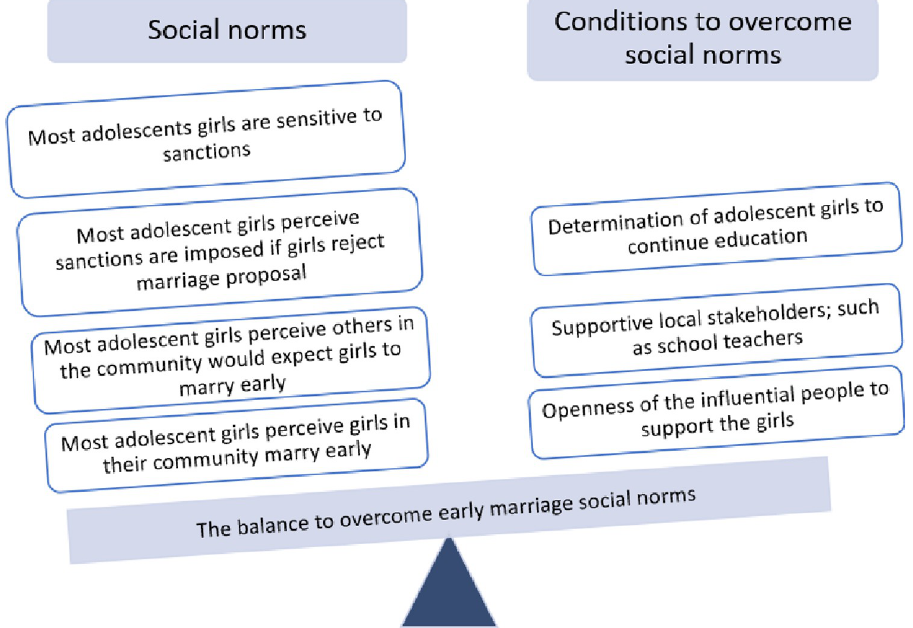
Fig 1. The balance to overcome social norms around early marriage in West Hararghe,